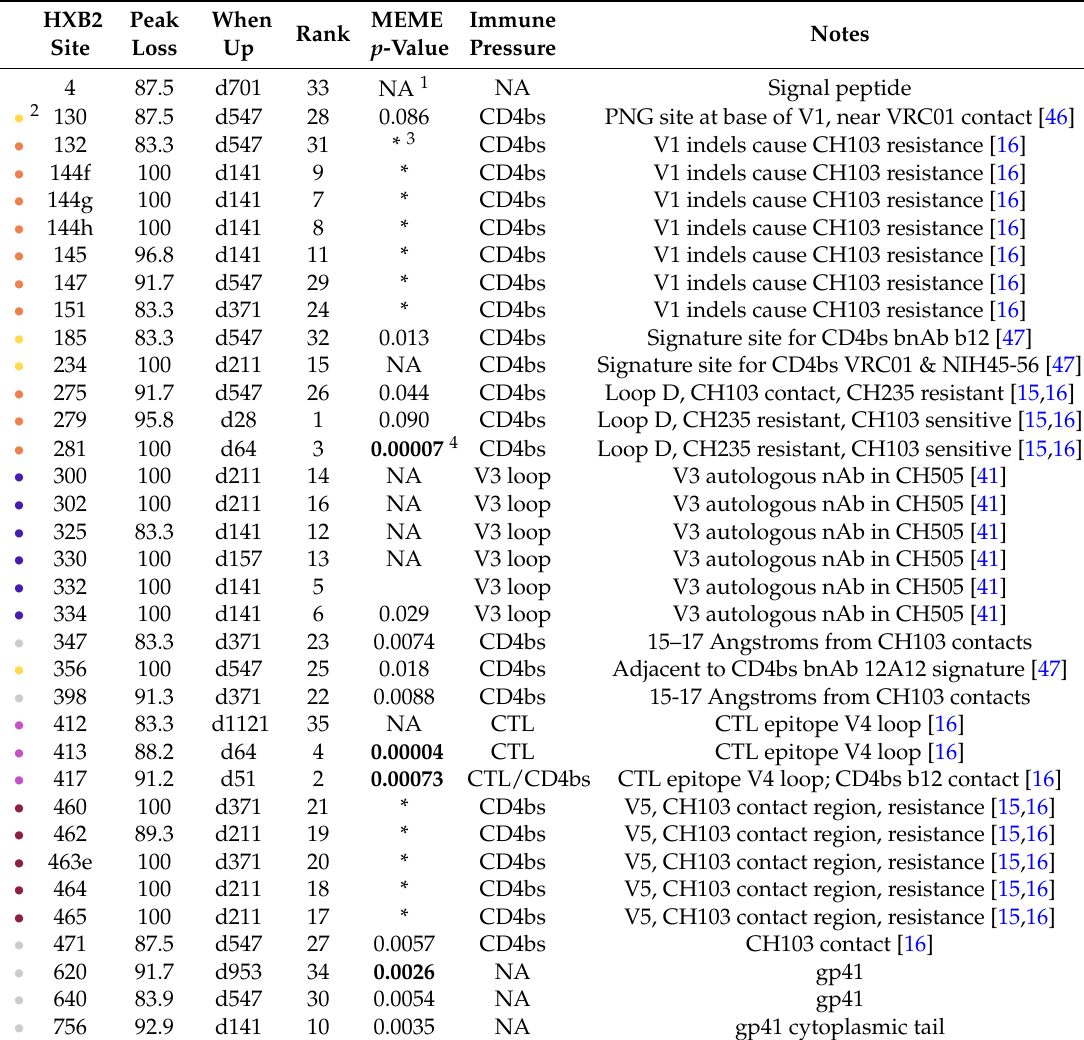
Table 1. Selected sites. Summary of the extent of TF loss and timing of the mutation in the subject. These CH505 Env sites showed at least 80% TF loss in at least one